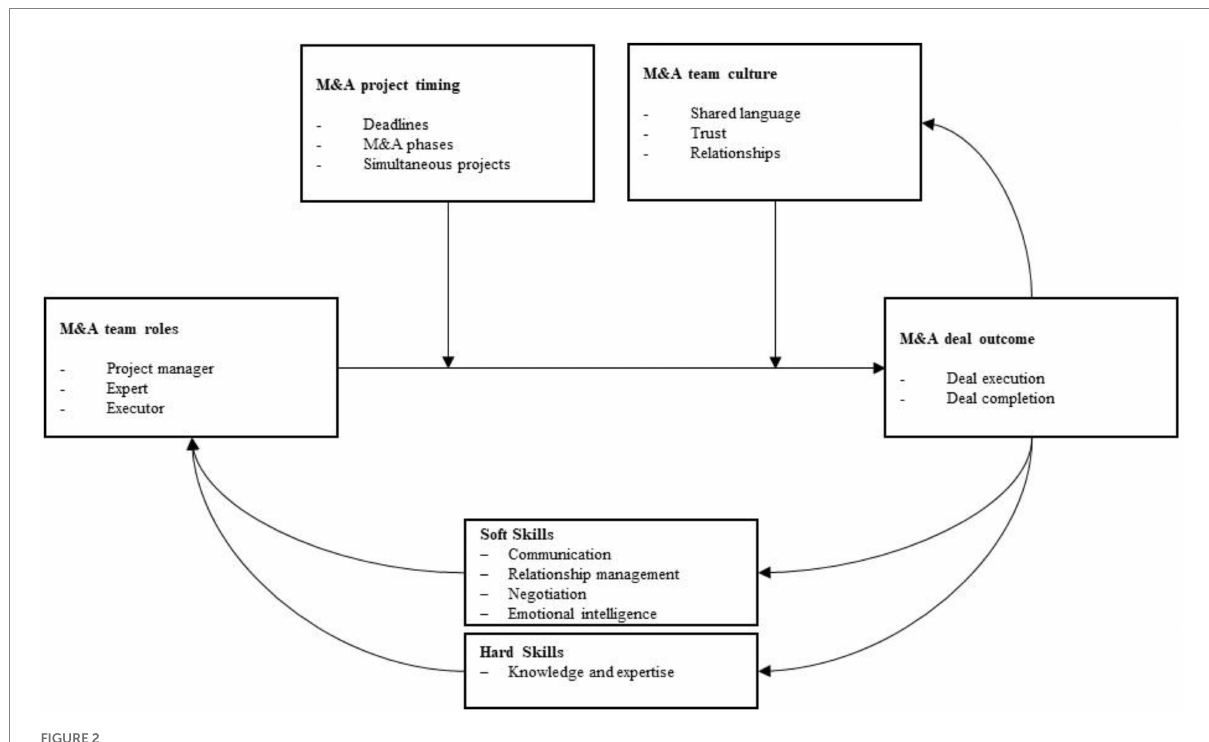
FIGURE 2 How M&A team roles and skills shape perceptions of M&A deal